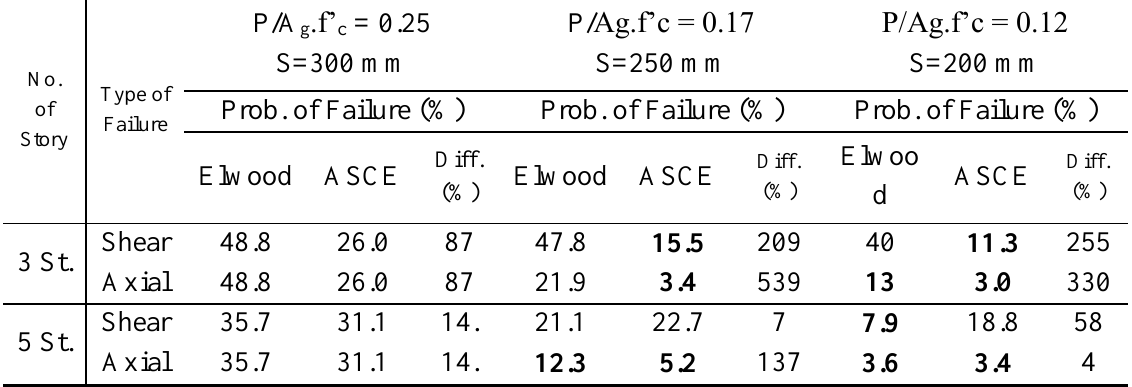
The Probability of shear and axial failure at first natural period of each frame for two employed modeling